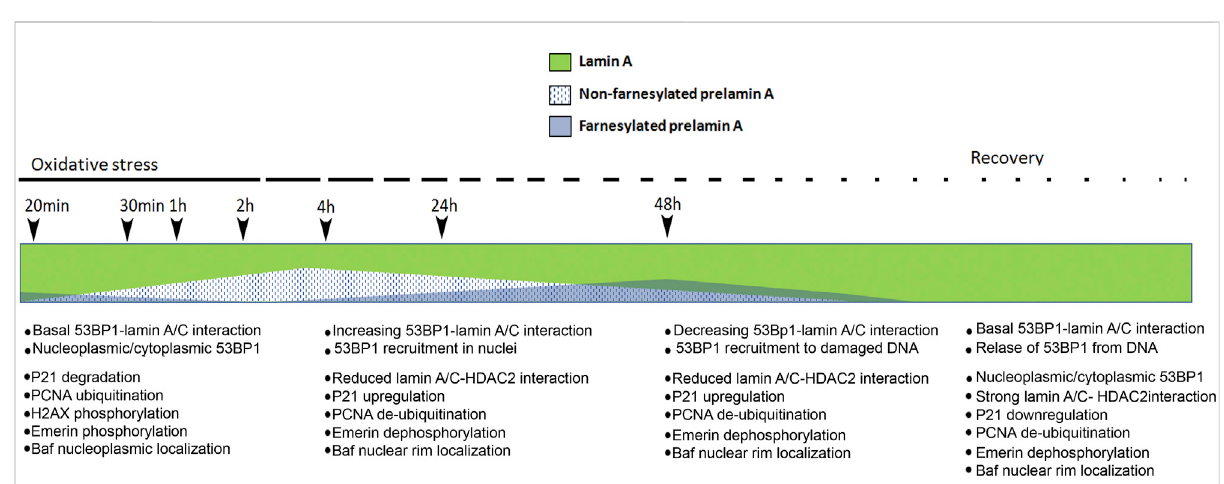
FIGURE 7 Schematicrepresentation ofourhypothesis onprelaminArole during oxidative stressresponseinnormal dermal fi broblasts.Modulationofthe relative amount oflaminA,non-farnesylated prelaminA and farnesylated prelaminA uponinductionofoxidativestress isrepresented. Previous data showed that non-farnesylated prelamin A is accumulated in normal dermal fi broblasts 4 h after H2O2 administration and it is reduced/absent 48 h after H2O2 administration, while farnesylated prelamin A is accumulated 48 h after stress induction and it is undetectable upon stress recovery andunderbasalconditions(Mattiolietal.,2019).Here,wehypothesizethatlevelsofmaturelaminA(green)decreaseuponslow-downofprelaminA processing, 53BP1 interactions and targeting and concomitant stress-related events are listed below the timeline. First list (20 min – 1 h from stress induction, no prelamin A): at the early stage of stress response, 53BP1 interacts with lamin A/C and lamin A/C contributes to its nucleoplasmic localization (Lattanzietal.,2007;Gibbs-Seymouretal.,2015)andtargetingto afewDNAdamagefoci.Other eventsinclude: p21degradation,PCNA ubiquitination, H2AX phosphorylation (this paper) and emerin phosphorylation (Cenni et al., 2020a). At this stage, emerin phosphorylation contributes to BAF release from emerin binding and BAF nucleoplasmic localization (Cenni et al., 2020b). Second list (4 h after stress induction, non farnesylated prelamin A accumulation): increased 53BP1-lamin A/C interaction elicits a low number of 53BP1 foci at DNA damage sites. In this condition, the following events occur: release of lamin A/C-HDAC2 interaction leading to p21 upregulation (Mattioli et al., 2019), PCNA de- ubiquitination(this paper),emerinde-phosphorylation(Cennietal.,2020a).Atthisstage,BAFisrecruited tothenuclear periphery duetoemerinde- phosphorylation (Cenni et al., 2020b) and BAF-prelamin A interaction (Loi et al., 2016). Third list (48 h after H2O2 administration, farnesylated prelamin A increase followed by lamin A maturation): lamin A/C-53BP1 interaction is reduced upon prelamin A farnesylation and lamin A maturation and 53BP1 is targeted to DNA damage foci. The other events include: increase of lamin A/C-HDAC2 interaction leading to p21 down-regulation (Mattioli et al., 2019), PCNA de-ubiquitination (this paper), emerin de-phosphorylation (Cenni et al., 2020a). At this stage, BAF is recruited to